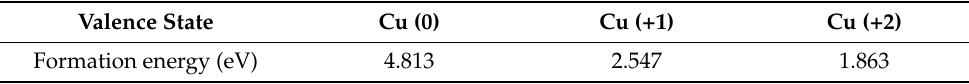
Table 2. Defect formation energies in HfO 2 at VBM ( ε f = 0